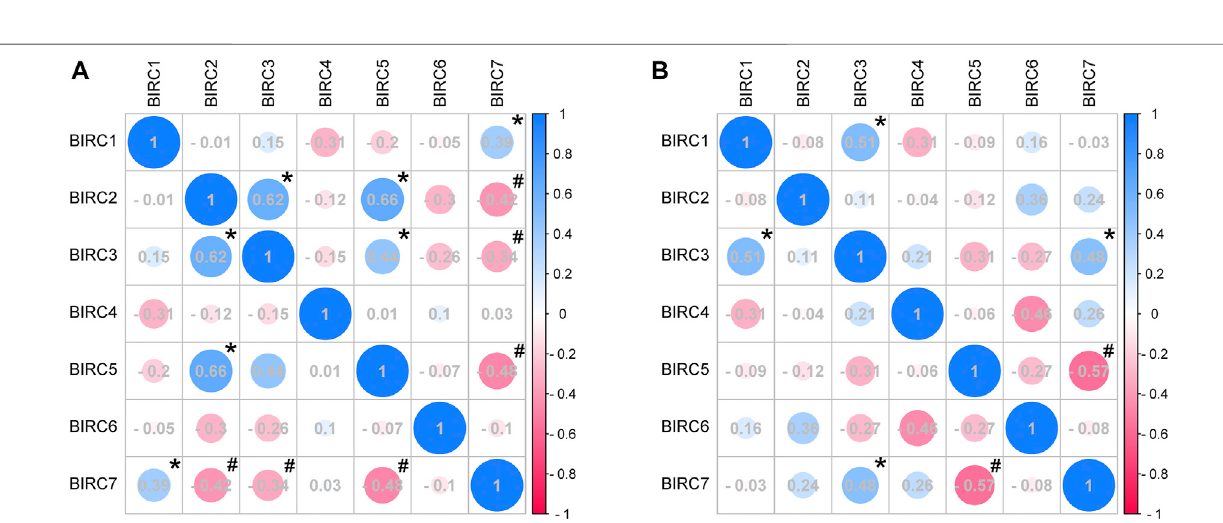
FIGURE 5 | Correlation analysis of mRNA expression of IAPs in NSCLC. (A) Correlation analysis of IAPs expression in LUAD. (B) Correlation analysis of IAPs expression in LUSC. NSCLC, non – small cell lung cancer; LUAD, lung adenocarcinoma; LUSC, lung squamous cell carcinoma. Pink indicates a negative correlation and blueindicatesapositivecorrelation;thedarkerthecolor,thelargethePearsoncorrelationcoef fi cient.*indicatesasigni fi cantlypositiverelationship( p < 0.05);#indicates a signi fi cantly negative relationship ( p <